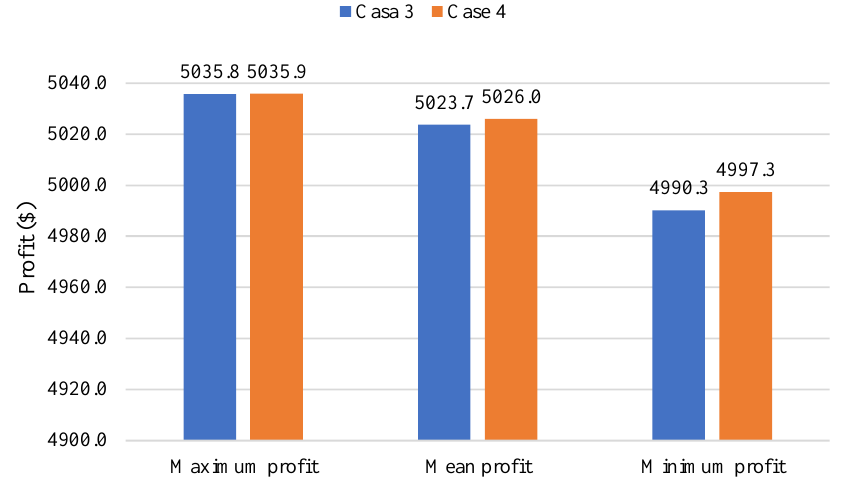
Figure 18. Comparison of profits from Case 3 and Case 4.